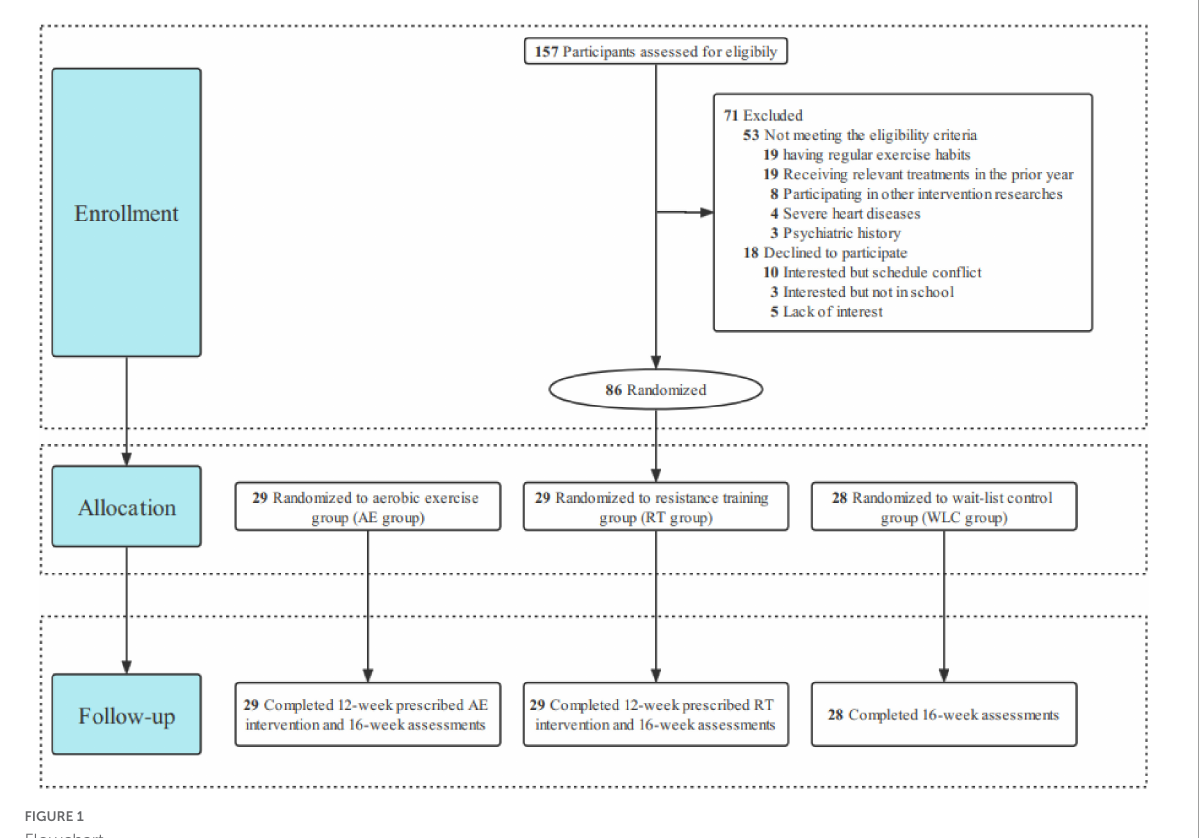
FIGURE1 Flowchart.